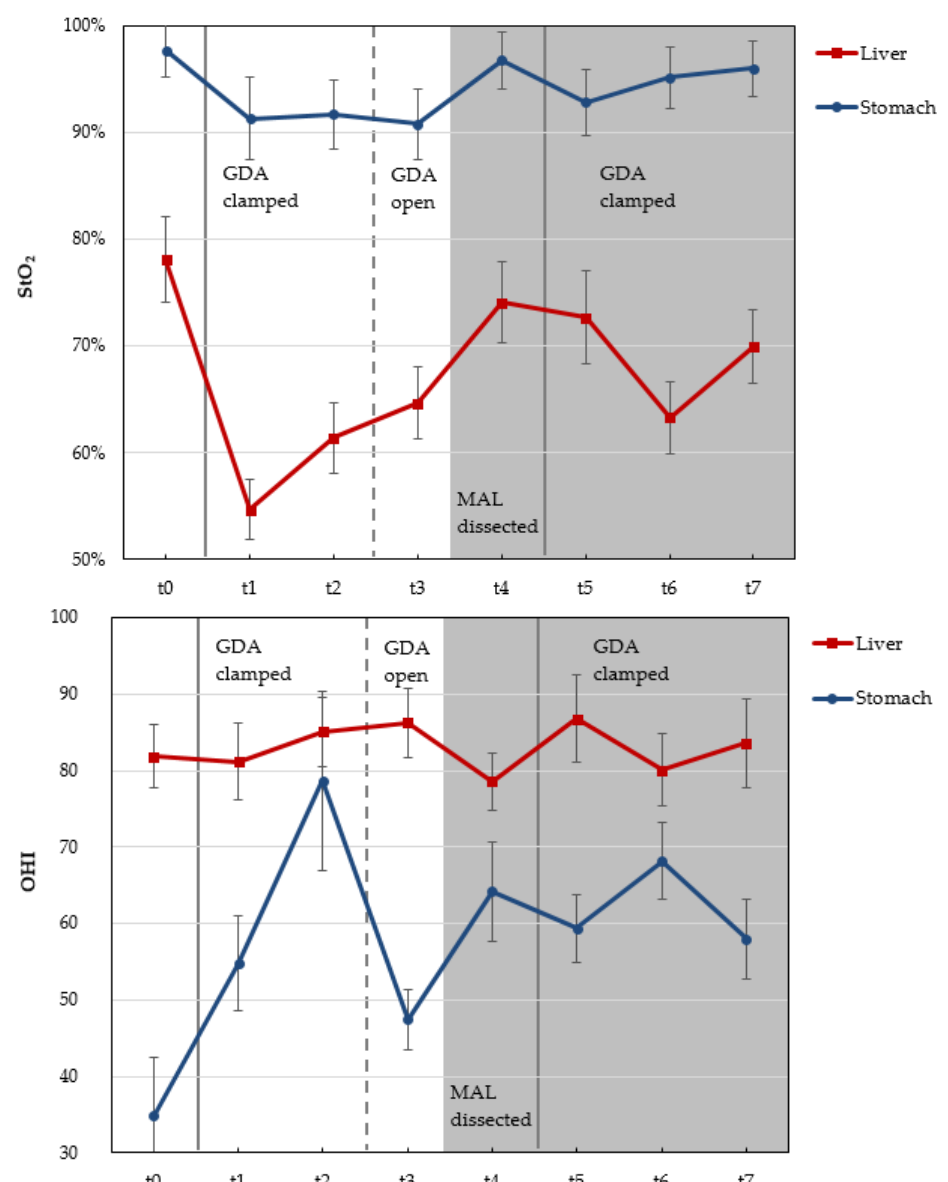
Figure 7. Course of liver oxyegnation (StO 2 in %) and liver hemoglobin content (OHI) (0–100) in the patient with CAS Type B before and after GDA clamping related to MAL dissection. t0 : before GDA clamping; t1 : directly after GDA clamping; t2 : 15 min after GDA clamping; t3 : directly after GDA re-opening; t4 : directly after MAL dissection; t5 : directly after GDA re-clamping; t6 : 15 min after GDA re-clamping; t7 : 30 min after GDA re-clamping. Gray areas show the time after MAL dissection (t4, t5, t6, t7). GDA: gastroduodenal artery; MAL: median arcuate